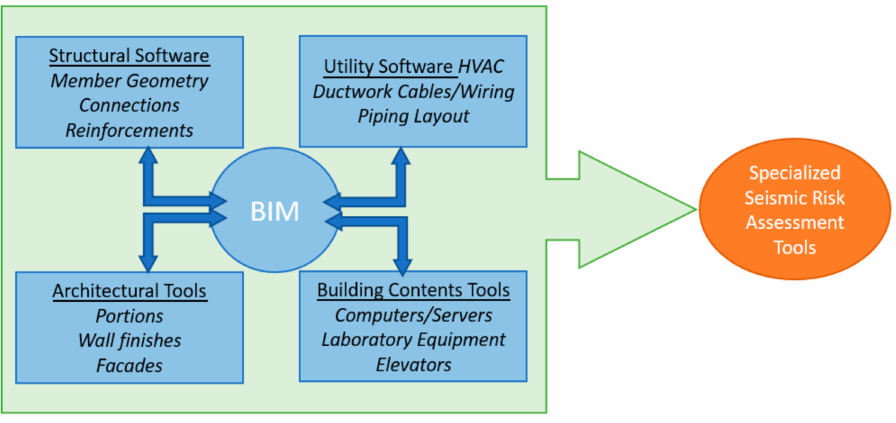
Figure 6. BIM models acting as a store for specialist seismic risk assessment tools